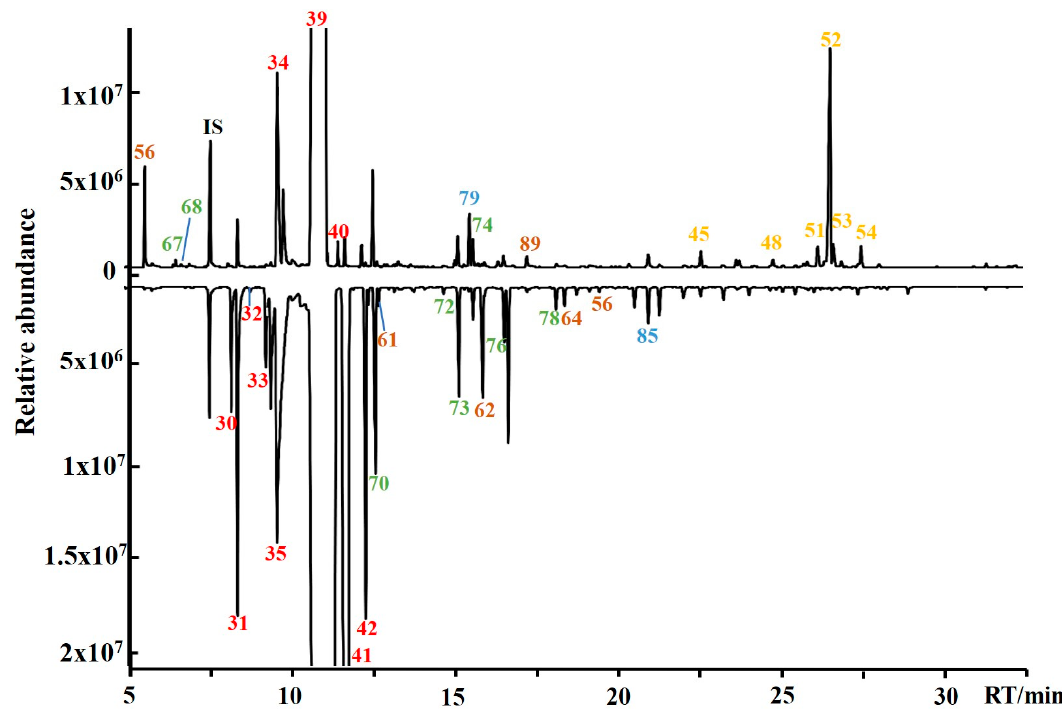
Figure 1. Total ion flow chromatogram of a typical sweet orange juice (above: Olinda Valencia orange juice) and a mandarin juice (below: Xinshengxi No.3 Ponkan juice). Compound numbers correspond to those in Tables 1 and 2. Each type of substance is shown in di ff erent colors: red: monoterpenes; yellow: